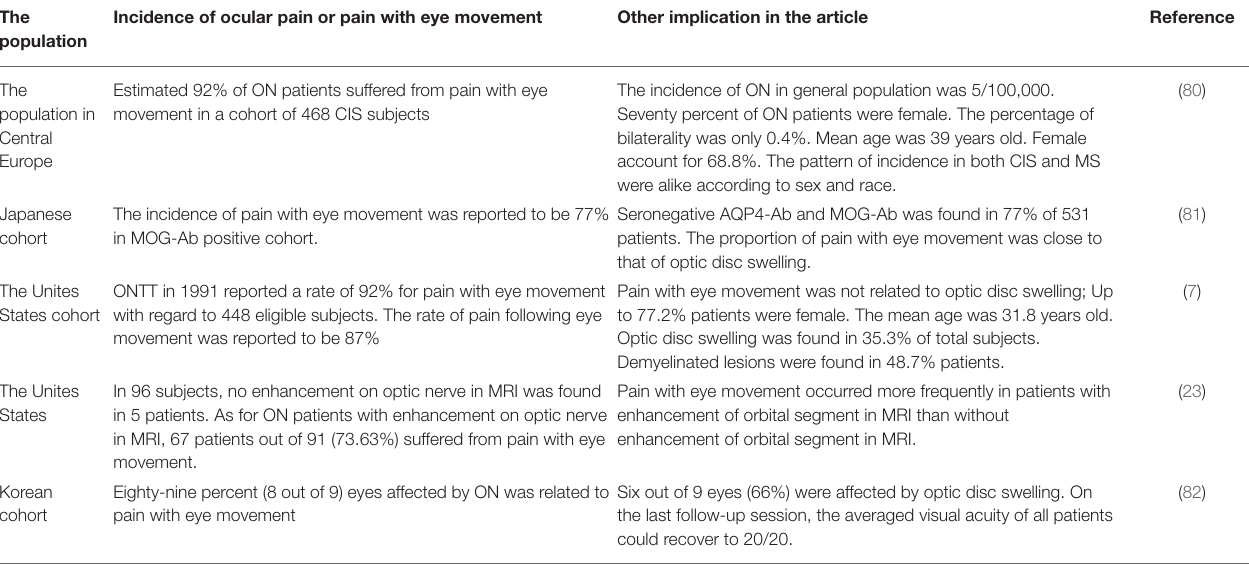
TABLE 4 | Overview of researches with respect to the incidence of ocular pain and pain with eye movement in ON patients. The Incidence of ocular pain or pain with eye movement population